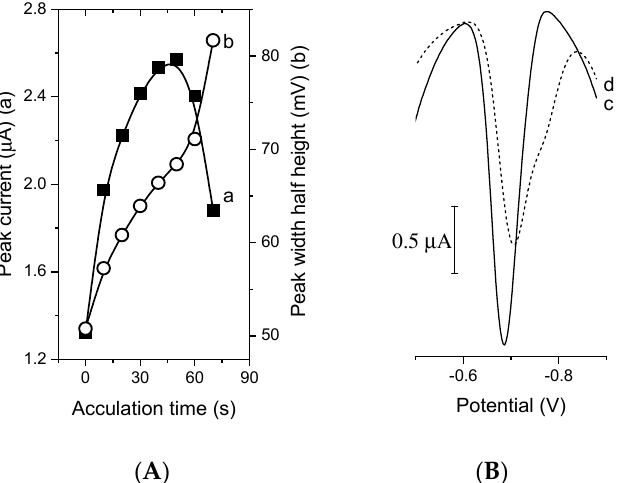
Figure 6. ( A ) Dependence of CAdSV peak current of Ge(IV) (a) and half width at half maximum (b) obtained using a BiF/GC electrode on accumulation time. ( B ) Voltammograms recorded after 30 s (c) and 70 s (d) of accumulation at a potential of − 0.4 V. Other parameters as in Figure 1. Finally, the dependence of the germanium peak current on germanium concentration was examined using BiFE/GC (Figure 7A), BiFE/SPE (Figure 7B), BiFE/SPE meso (Figure 7C), and BiFE/SPE or-meso (Figure 7D) in a solution containing 0.05 M acetate buffer, 1 mM of catechol, 1 mM of V(IV), and 1.5 mM of HEDTA, with 30 s of adsorptive accumulation at − 0.4 V in a stirred solution. The calibration parameters presented in Table 1 show that procedures that employ BiFEs for the determination of Ge(IV) have the same advantages as those utilizing the HMDE electrode (namely high sensitivity and reproducibility of germanium(IV) CAdSV signals) [10].